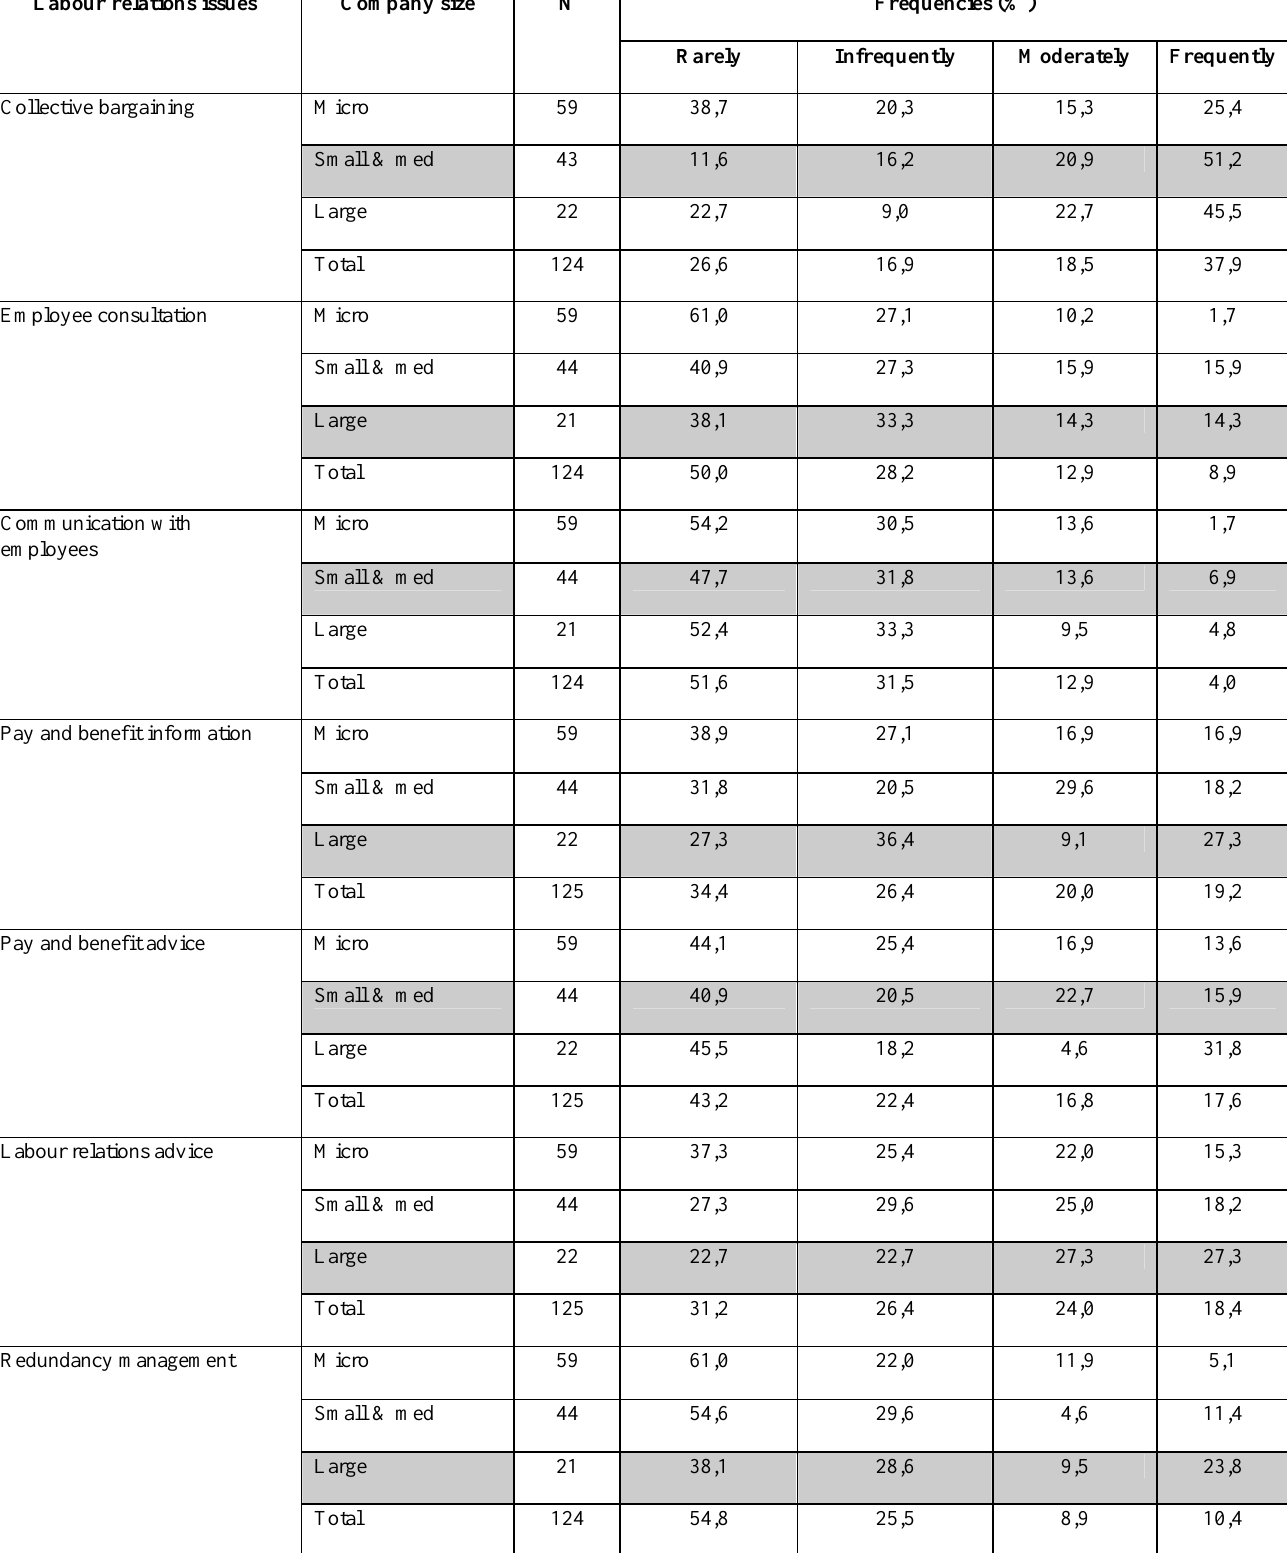
Table 6: Comparison between company size and responses to labour relations issues Labour relations issues Company size N Frequencies (%) Rarely Infrequently Moderately